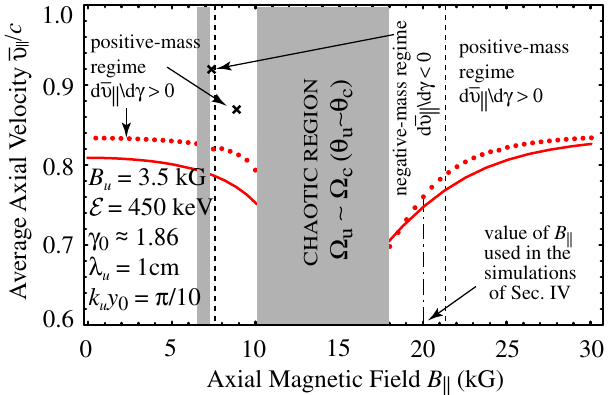
FIG. 4. The average axial velocity is a function of the axial magnetic field. The curves and the dots are for the analytical formulas (17) and (18) and the simulation results,